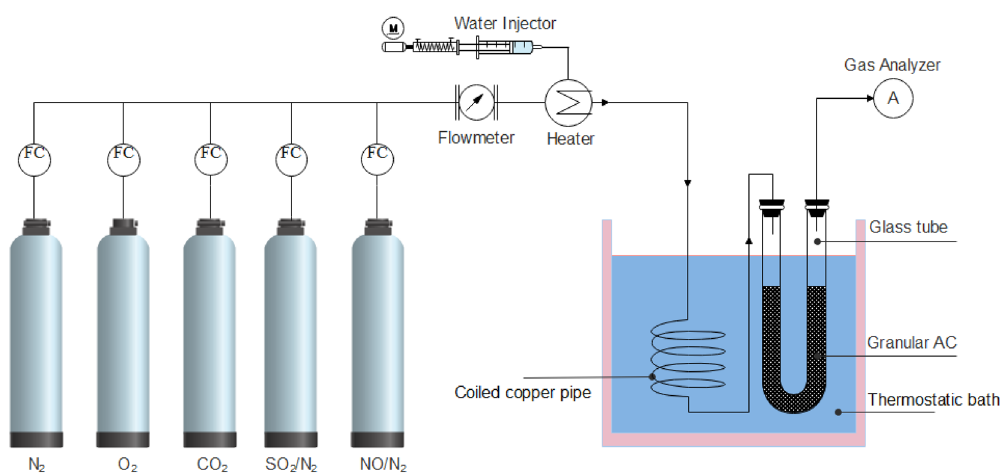
Figure 3. Experimental setup for low-temperature adsorption of SO 2 and